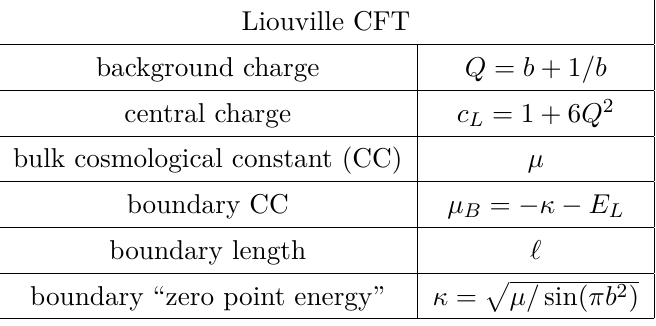
Table 1 . The parameters in the Liouville